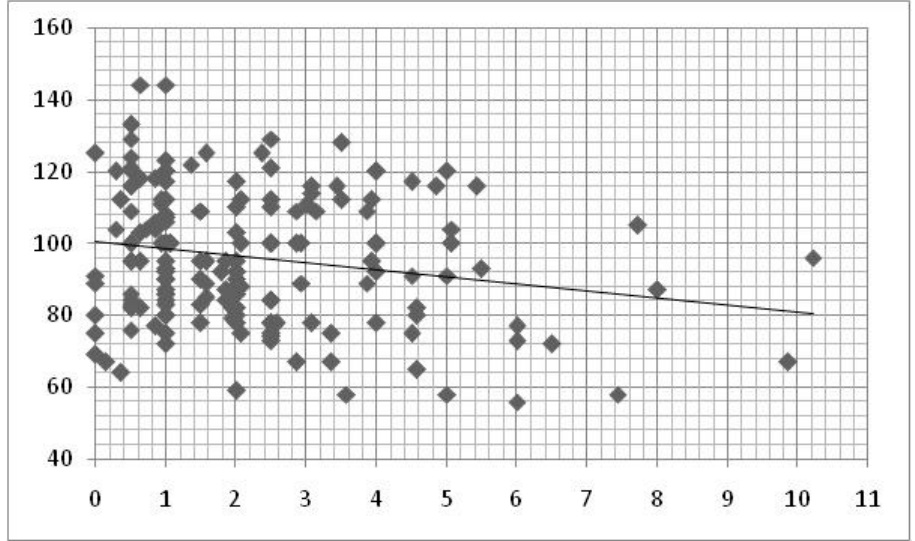
Figure 2. Linear regression between time of DD use by the children and Lexical Quotient . x axis = hours / day of DD use; y axis = Lexical Quotient scores.